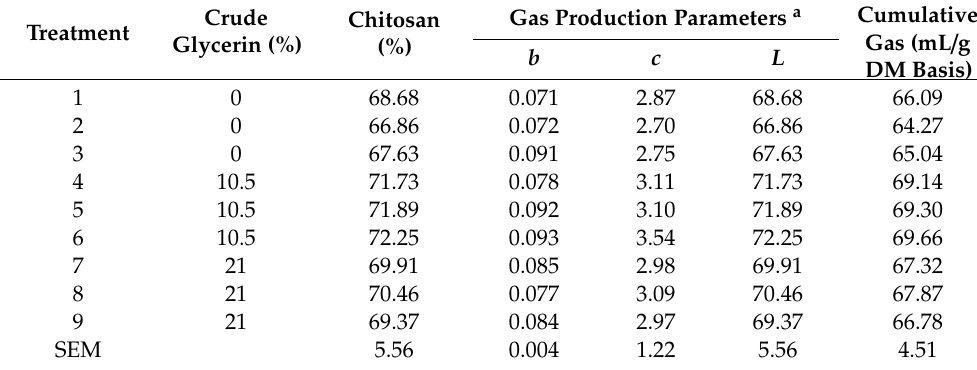
Table 2. Supplementation of glycerin with chitosan on in vitro gas kinetics and cumulative gas production at 96 h after